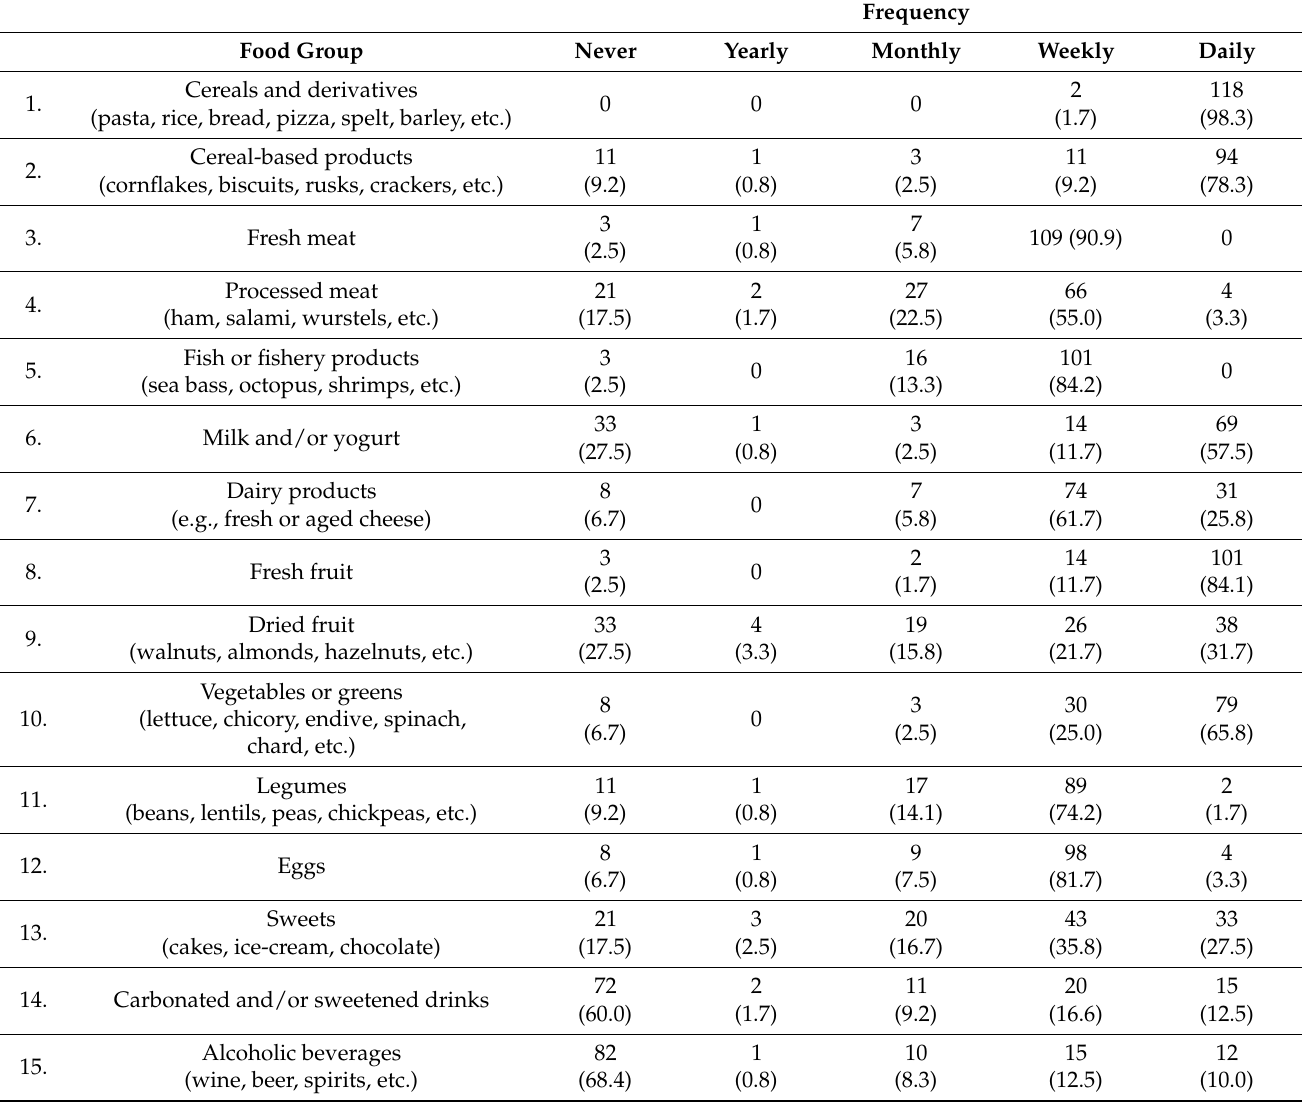
Table 2. The INRAN questionnaire: frequencies of consumption for different food